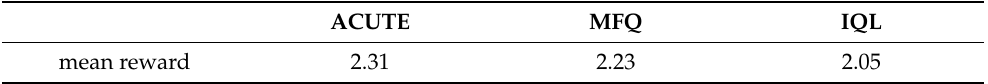
Table 4. Mean reward per episode on ma-gym: